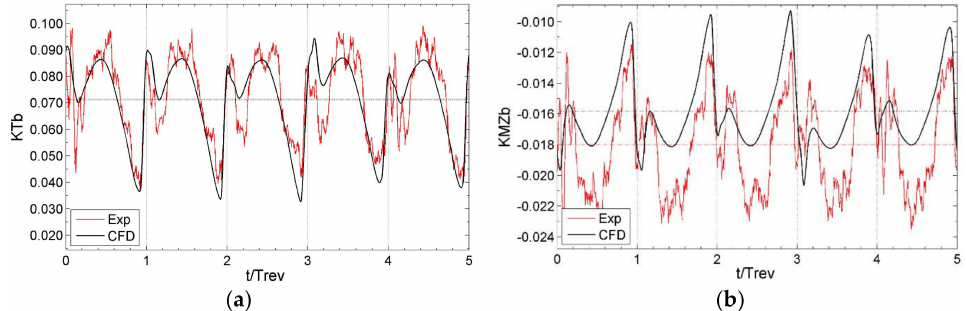
Figure 15. Measured and computed time histories of blade loads at J = 0.6 for the heading angle +35 ◦ :